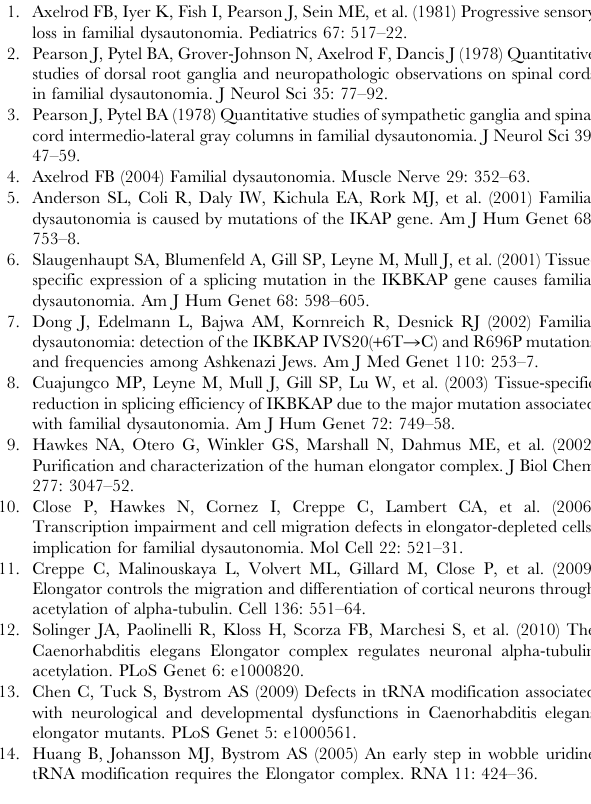
intensities were treated with the SAM software to highlight the most differentially expressed genes, with a FDR set at 3%.